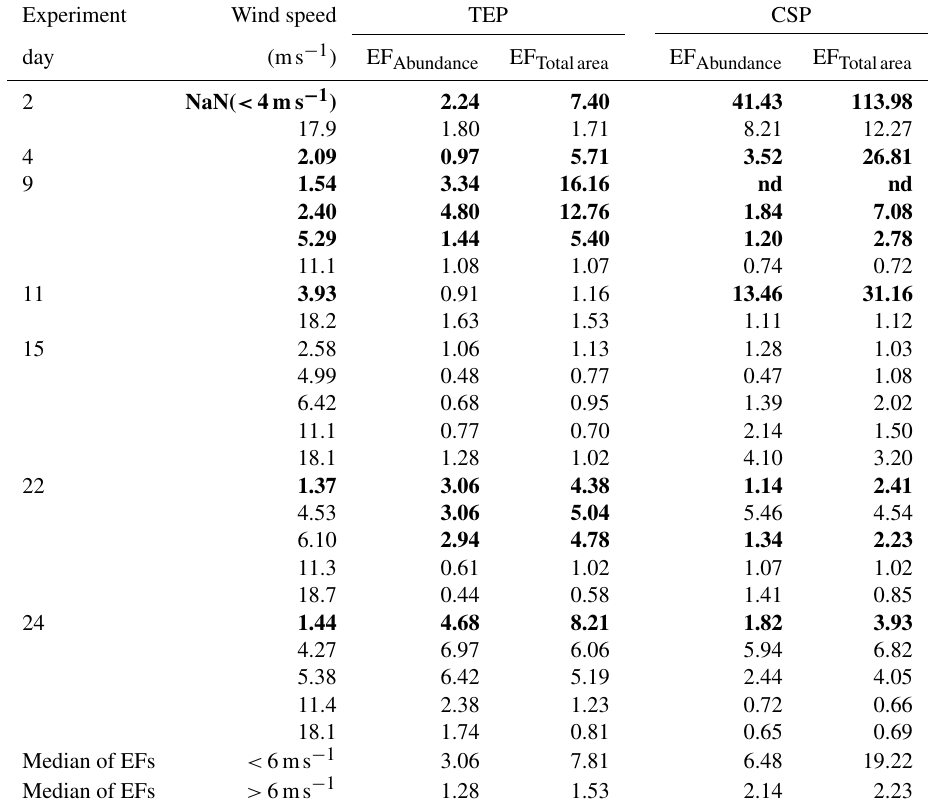
Table 2. Enrichment factors (EFs) for gel particle abundance and total area in the SML at different wind speeds; (EF Totalarea > EF Abundance are marked